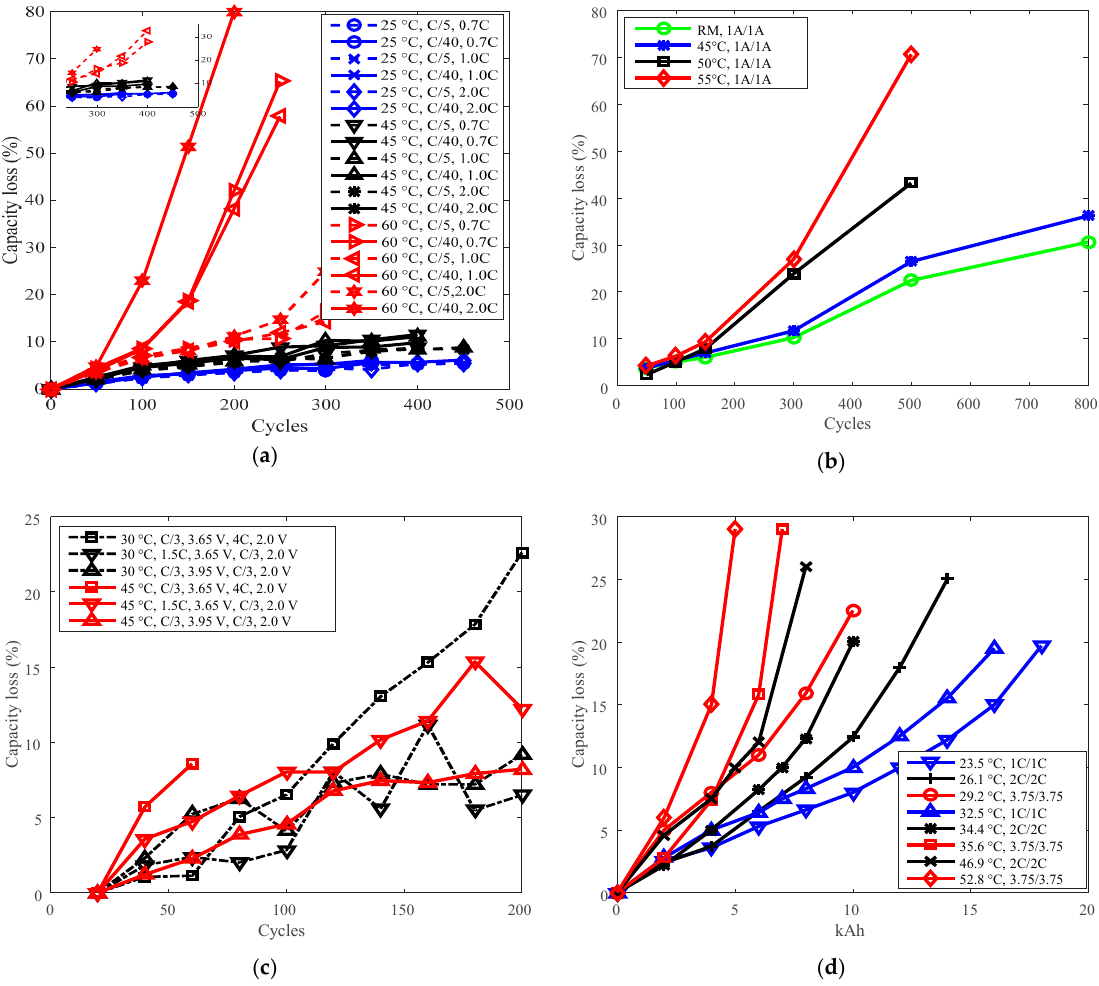
Figure 4. Battery cycle degradation data under various temperatures. (a) Capacity loss vs. cycles for battery A, “25 °C, C/5, 0.7C” refers to charge cut-off current C/5, charge C-rate 0.7C under 25 °C. (b) Capacity loss vs. cycles for battery B, “RM, 1 A/1 A” refers to charge/discharge current 1 A under room temperature. (c) Capacity loss vs. cycles for battery G, “30 °C, C/3, 3.65 V, 4C, 2.0 V” refers to cells charged constant current (CC) C/3 to 3.65 V, discharged CC 4C to 2.0 V under 30 °C. (d) Capacity loss vs. total capacity throughput for battery P, “23.5 °C, 1C/1C” refers to charge/discharge C-rate 1C under 23.5 °C. The degradation is presented as a function of total capacity throughput over the entire cycle life, the unit is kiloampere hour (kAh).